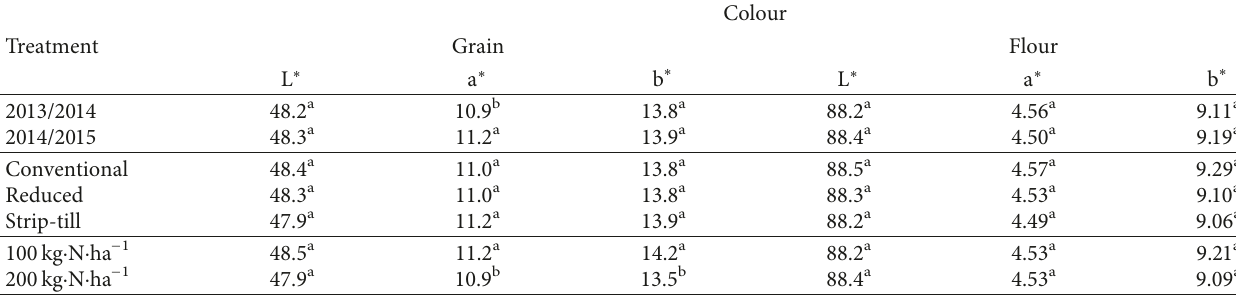
Table 5: Properties of bread depending on the environmental and agronomic conditions of grain production—experimental treatments. Treatment Bread volume (cm 3 )